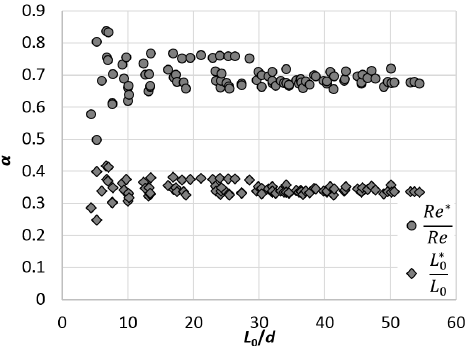
Figure 9. The average-to-centerline ratio vs. the dimensionless stroke length.